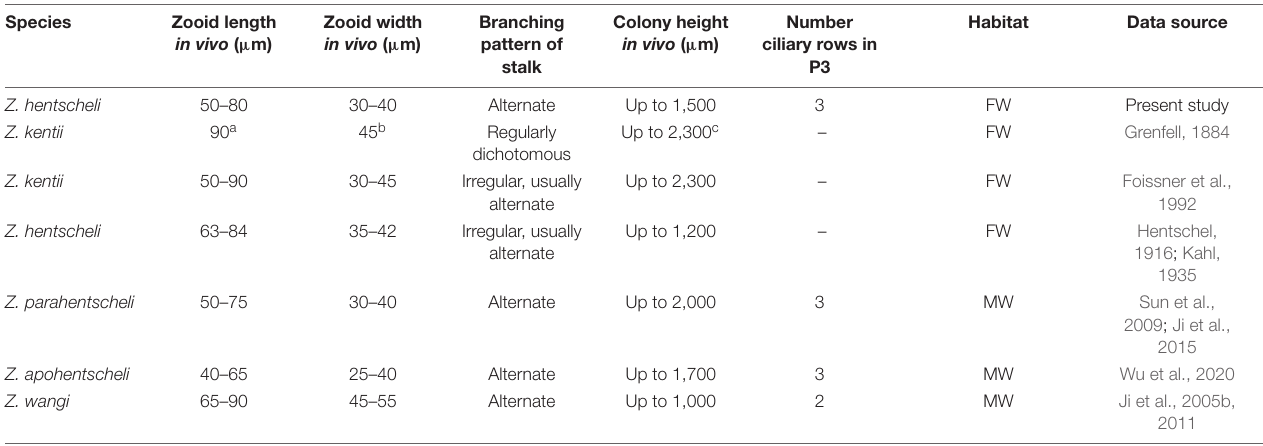
TABLE 3 | Comparison of Zoothamnium hentscheli (Weishan population) with other populations and closely related congeners. Species Zooid length in vivo ( µ m)